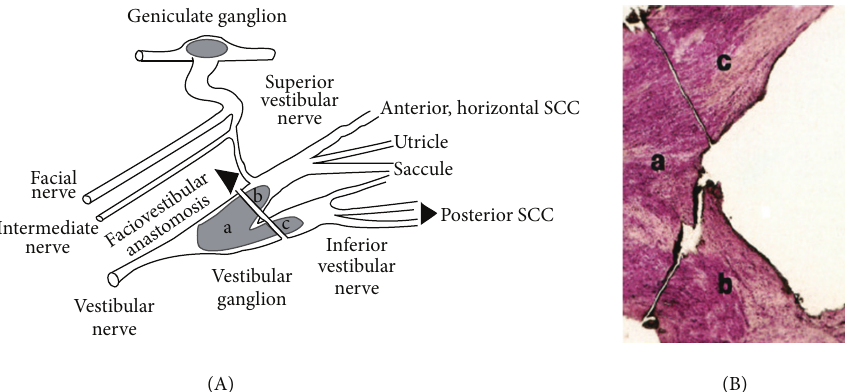
Figure 2: (A) schematic drawing of vestibular and facial nerves. Different section of vestibular ganglion (a) sterm, (b) inferior portion, and (c) superior portion. (B) Longitudinal section of human vestibular ganglion (a) sterm, (b) inferior portion, and (c) superior portion. Using polymerase chain reaction, herpes simplex virus 1 (HSV-1) DNA was found in 60% of the human esamine ganglia (from Arbusow et